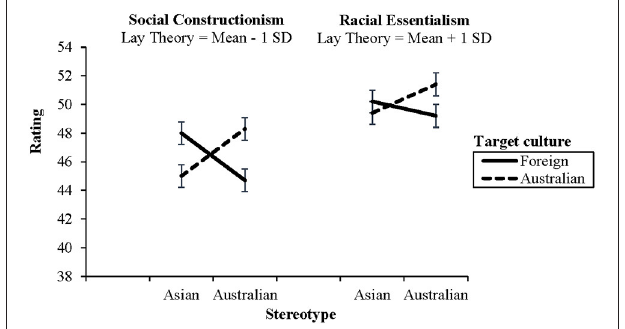
FIGURE 1 | Ratings of Asian and Australian stereotypes as an effect of lay theory of race when target culture was foreign or Australian, computed at 1 sd above and below the mean for lay theory of race. Error bars are standard